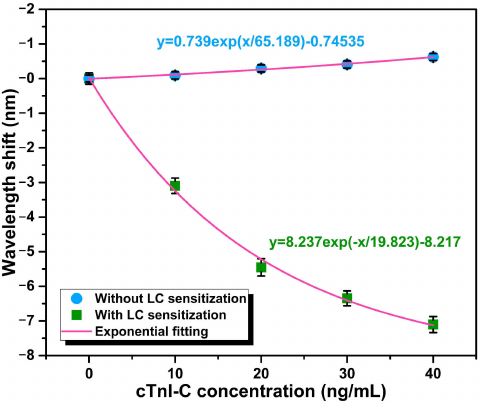
Figure 6. Relationship between the resonant wavelength shifts and the cTnI-C concentration.